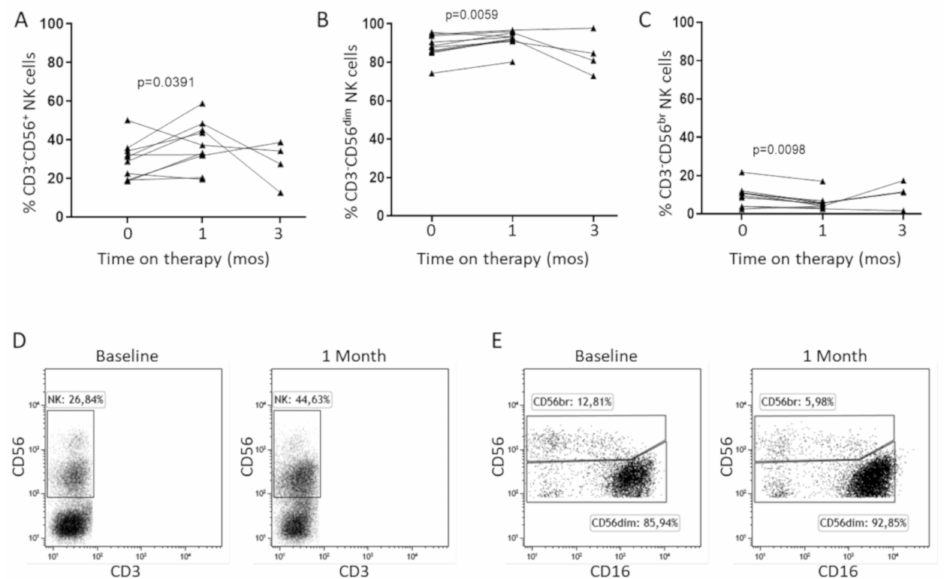
Figure 4. NK cell subset distribution in HCC patients treated with sorafenib. Frequencies of total ( A ), CD56 dim ( B ), and CD56 bright ( C ) NK cells in HCC patients before ( n = 10) and after 1 ( n = 10) and 3 ( n = 4) months of sorafenib treatment. The Wilcoxon matched-pairs signed rank test was used to analyze data. Panel ( D ) and Panel ( E ) show representative dot plots of total CD56 dim or CD56 bright NK cells at baseline and 1 month on